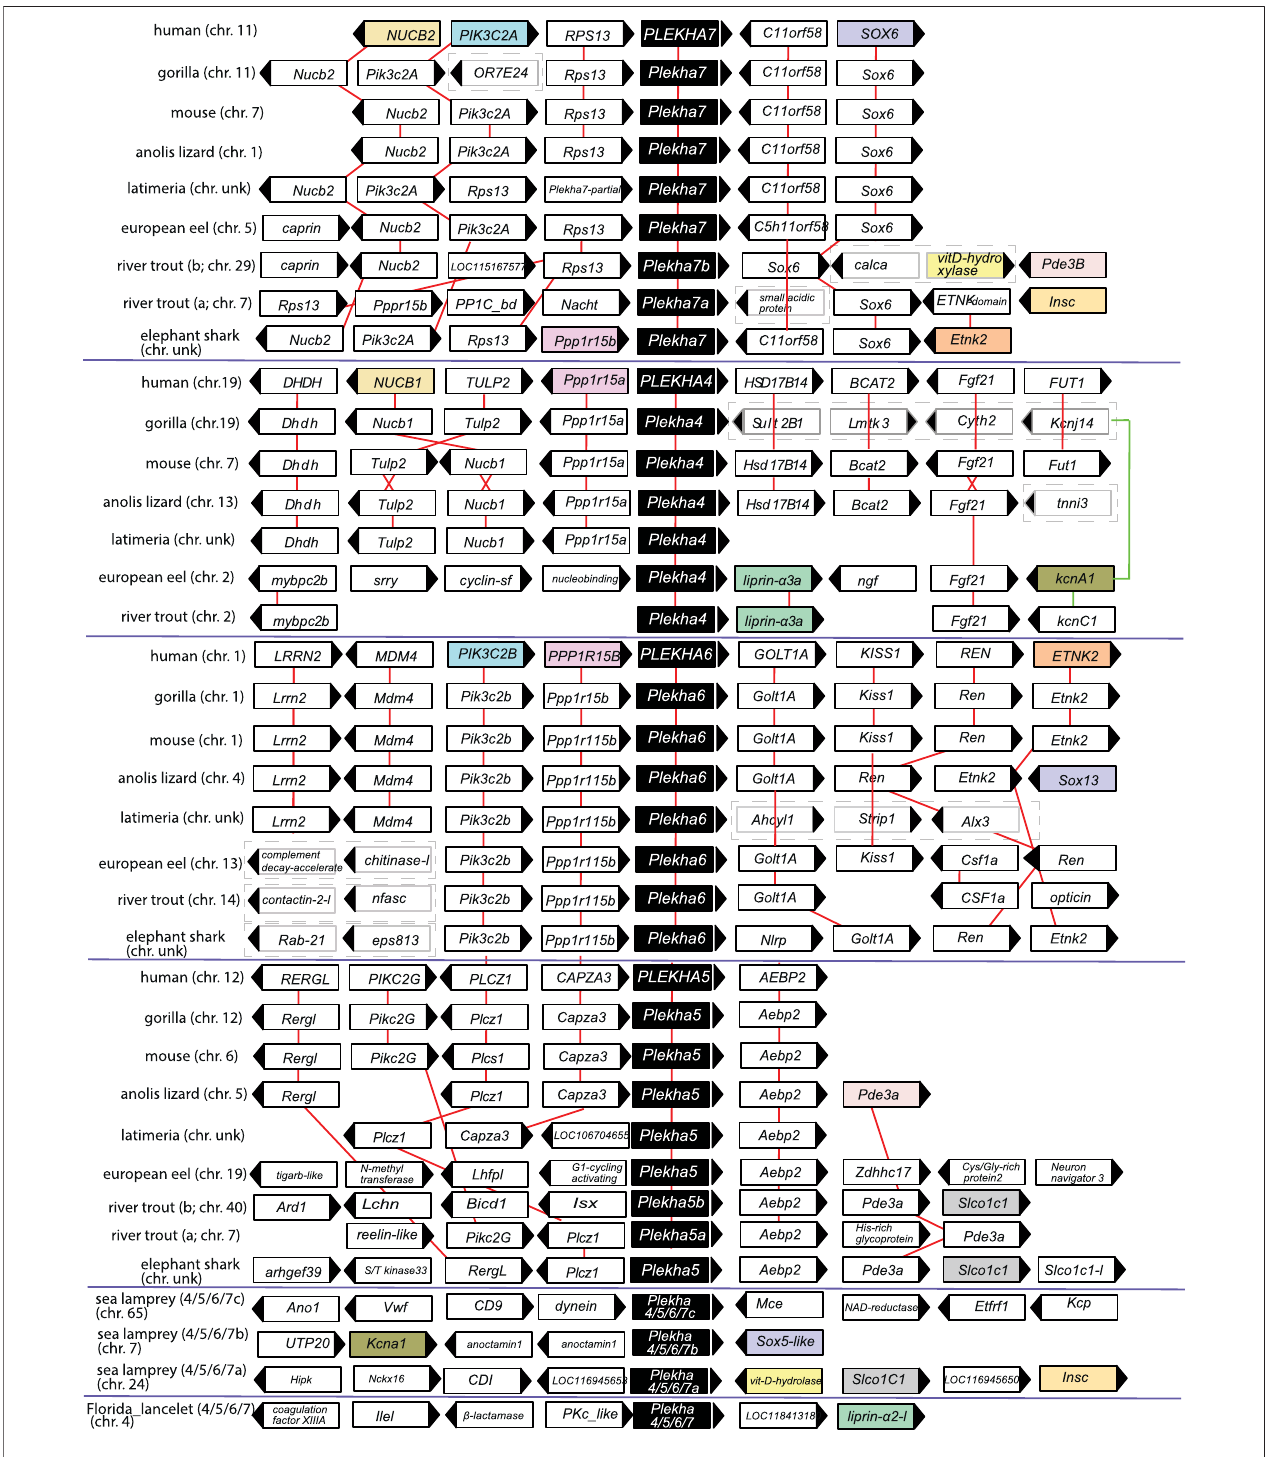
FIGURE4| Thegenomicorganizationofthe Plekha4,5,6,7 lociisrelativelyconservedwithinchordatesandrevealsancientgenomicduplicationevents.The fi rstfourprotein codinggenesandupto500 kbps fl ankingrepresentative Plekha4,5,6,7 lociwerecollectedfromGenBankusing in-house scripts(seeMethodsand SupplementaryFigureS10 for complete dataset). The gene name and domain information for each locus were collected and analyzed to suggest homology and determine conserved synteny. Pairwise alignments were used as needed to supplement the above analyses. Genes are represented as arrows and each arrow ’ s direction represents the gene ’ s transcription orientation.Informationofthechromosome(chr.)isalsoprovidedifknownasanumberorwiththeabbreviationunk(ifunknown).Redlinesconnectorthologousgenes.Genesfrom humansor fi shesarerepresentedascoloredboxesonlyiftheyweresharedatleastbetweentwoparalogousgenegroups.Casesoflossofsyntenyarerepresentedwithdashed boxes around the genes. Teleost-speci fi c copies are indicated by a, b; lamprey-speci fi c copies are indicated by 4/5/6/7a,b,c. The graph is not in scale for clarity.